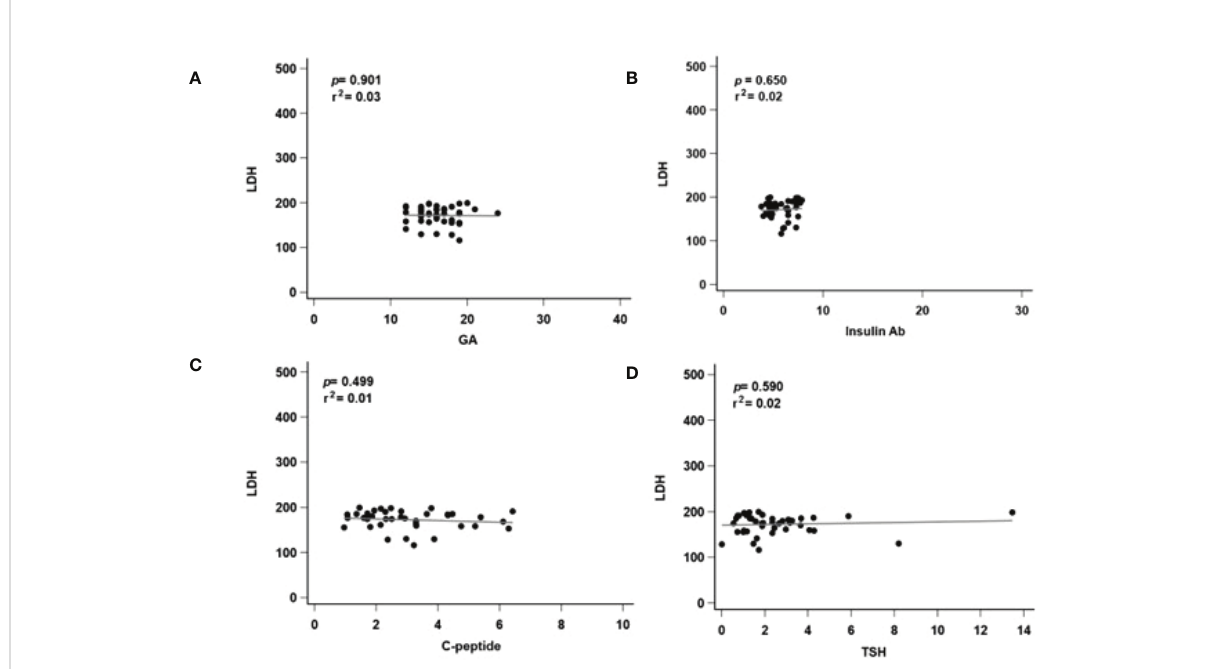
FIGURE 4 Regression analysis of related markers in low serum level of LDH groups. LDH, lactate dehydrogenase; GA, glycated albumin; C-peptide, connecting peptide; insulin Ab, insulin antibodies; TSH, thyroid-stimulating hormone. (A) The correlated with serum LDH and GA level. (B) The correlated with serum LDH and insulin Ab level. (C) The correlated with serum LDH and C-peptide level. (D) The correlated with serum LDH and TSH level. p , p-value; r 2 :